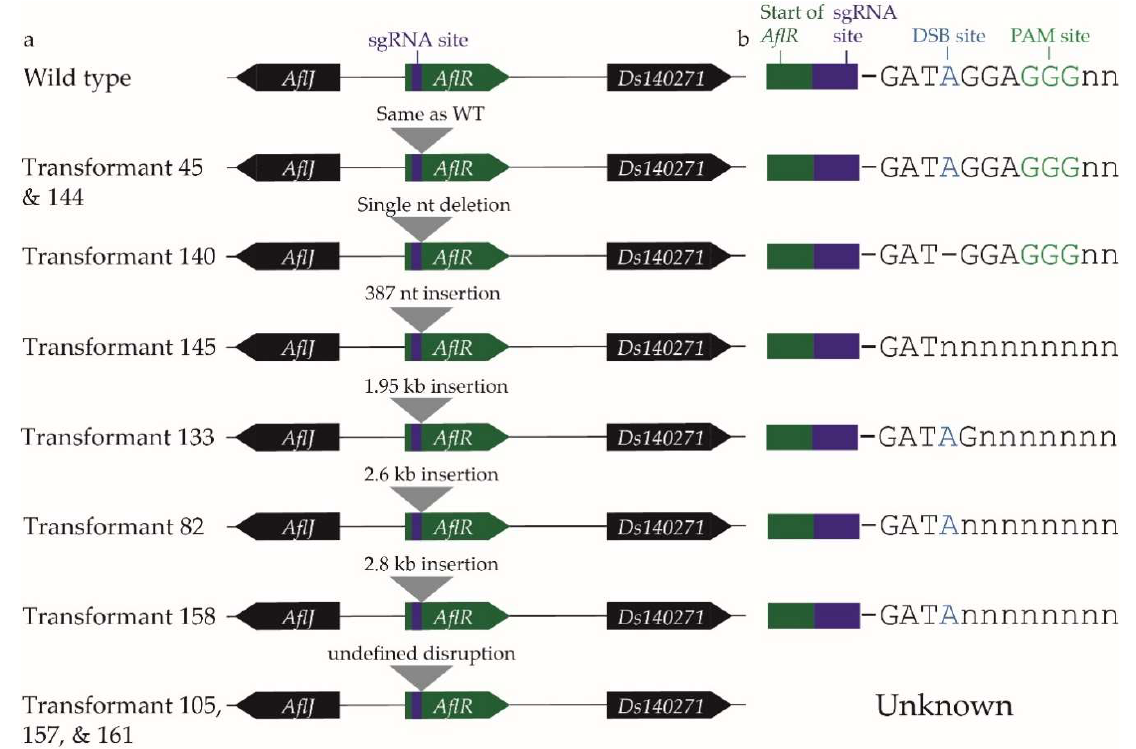
Figure 3. Summary of mutations identified from Dothistroma septosporum AflR CRISPR/Cas9 transformants. ( a ) Visual representation of AflR locus including flanking genes in each transformant. Purple bar in AflR is the CRISPR/Cas9 sgRNA AflR2 binding site. Mutations, if present, indicated by a grey triangle and labelled with type of mutation identified through phenotype, PCR analysis, and PCR amplicon sequencing. ( b ) Specific locations within sgRNA AflR2 binding site where CRISPR/Cas9 disruptions were observed. sgRNA AflR2 binding site is 23 bp; end with double-strand break (DSB) site (in blue) and protospacer adjacent motif (PAM) site (in green) shown as nucleotides, and the rest illustrated by a purple bar. Where a transformant had an insertion, the insertion start position is shown through truncation of the sgRNA AflR2 binding site sequence. Single-nucleotide deletion in transformant 140 shown by a dash in the sequence. For transformants 105, 157, and 161, no PCR amplification was achieved in the AflR region; therefore, no sequencing was performed (labelled “undefined/unknown”).